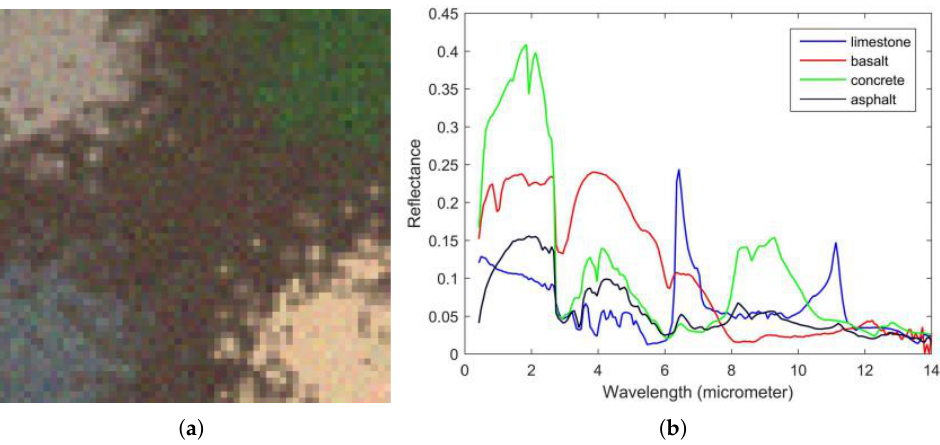
Figure 3. Synthetic image: ( a ) Synthetic color image (488, 566, and 693 nm) ( b ) Mean spectra extracted from the ASTER library.